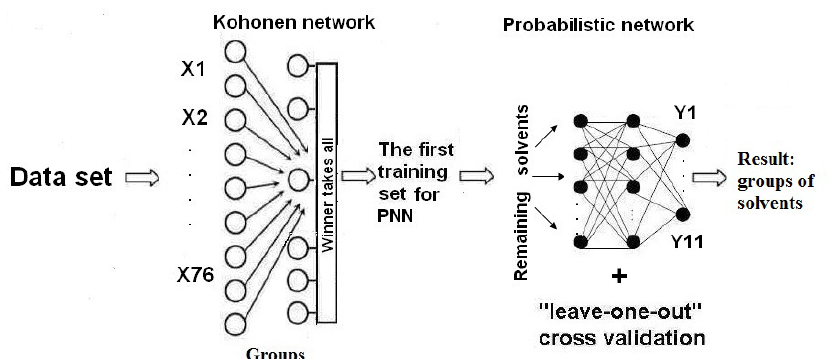
Figure 1. The scheme of the proposed classification procedure based on a combination of the Kohonen and the probabilistic neural